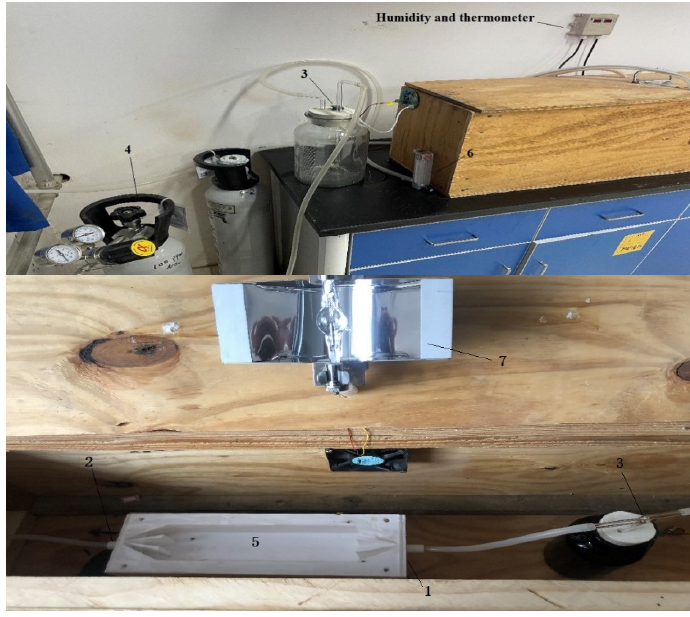
Figure 1. Photocatalytic system. (1) Reaction mold; (2) Running-in interface; (3) Probe; (4) Nitrogen dioxide bottle; (5) Cover plate; (6) Flow rate control; (7) Xenon lamp; (8) Waste bottle.